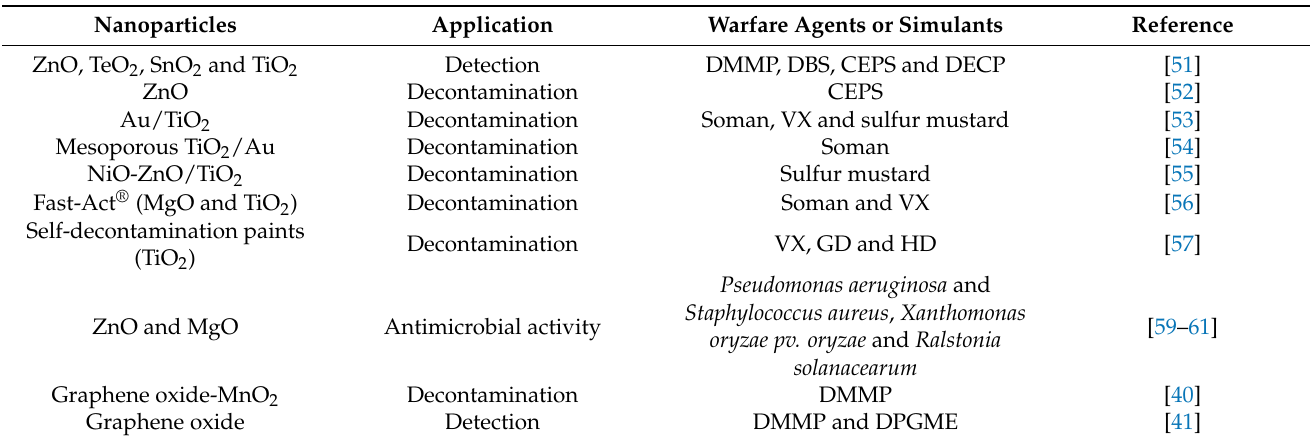
Table 2. Literature examples of the use of metal and metal oxide NPs for the decontamination/detection of warfare agents/simulants